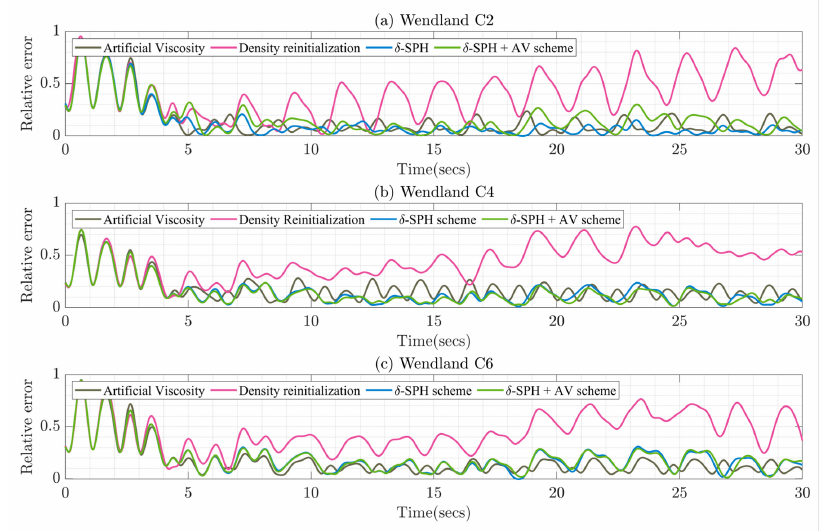
Figure 14. Comparisons of errors in wave elevations obtained with the different numerical dissipation schemes for the three different Wendland